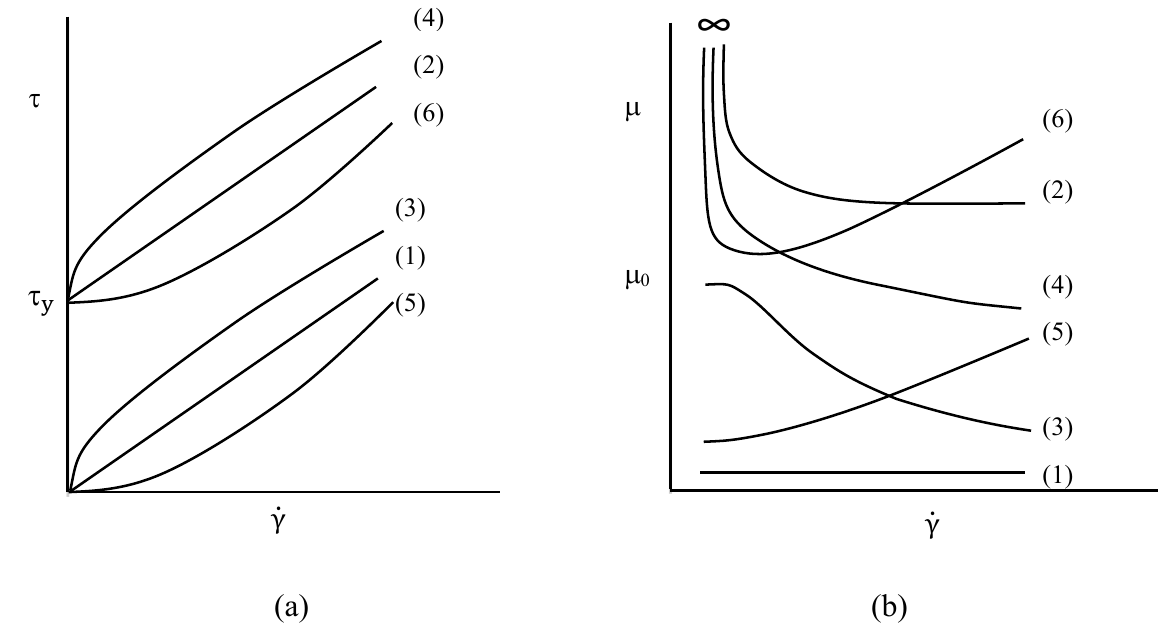
Figure 5: Rheological behavior of different fluids: (a) flowcurve; (b) viscosity as a function of shear rate. (1) Newtonian, (2) Bingham (Plastic), (3) Shear thinning (pseudoplastic), (4) Shear thinning with yield stress ( τ y ), (5) Shear thickening (dilatant), (6) Shear thickening with yield stress ( τ y ). Modified from [3]